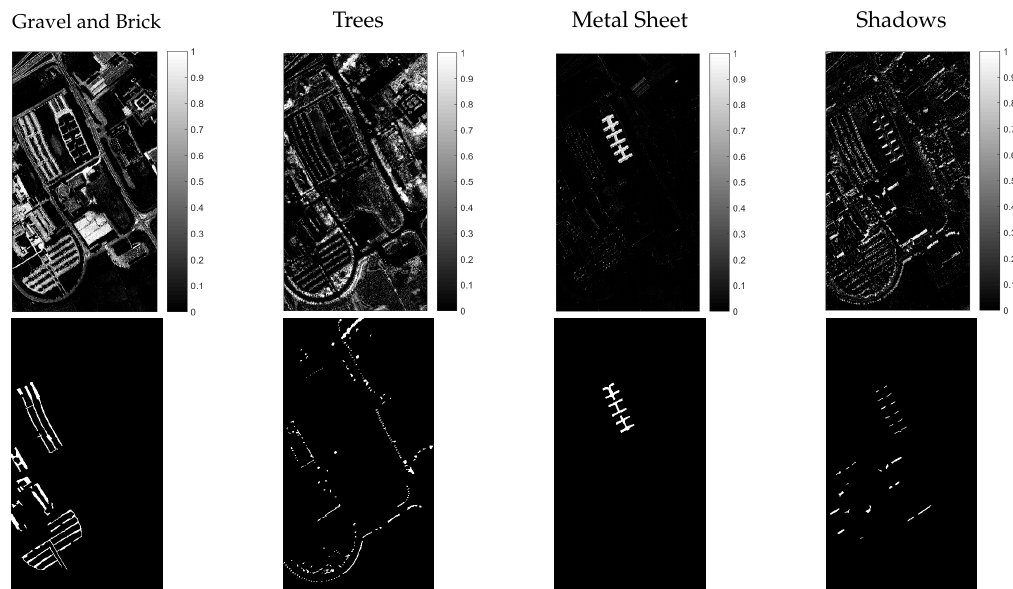
Figure 27. Comparison between extracted abundance maps and binary class maps from reference data. The top row shows the abundance maps and the bottom row the binary class maps from the reference data.